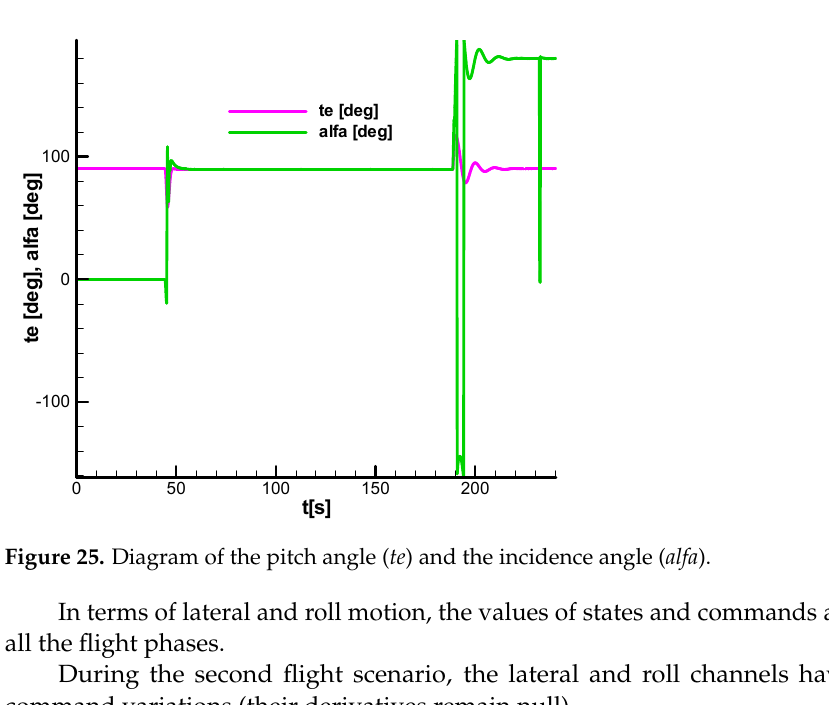
Figure 27. Maximum distance for horizontal evolution—second scenario. Figure 27 shows that maximum distance increases with velocity and decreases with the horizontal flight altitude. The maximum distance obtained by vehicle was (cid:1830)(cid:1865)(cid:1853)(cid:1876) = 3.52 km , corresponding to (cid:1848) = 15 [m/s] and an altitude of horizontal flight (cid:1834) = 0.1 [km] . Additionally, from Figure 27, we can observe a restriction of the flight envelope due to the exceedance of the final velocity (cid:3435)(cid:1848) (cid:3033)(cid:3036)(cid:3041)(cid:3028)(cid:3039) (cid:3040)(cid:3028)(cid:3051) = 2 [m/s](cid:3439), fuel consumption and